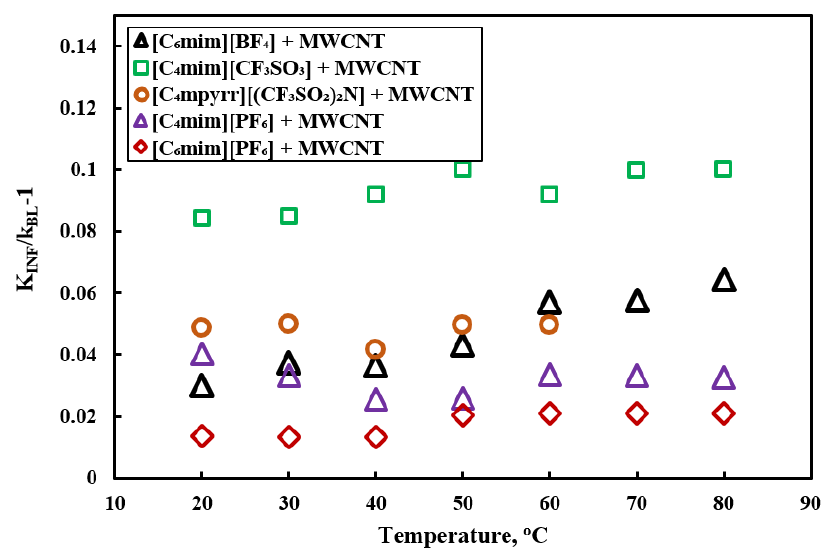
Figure 10. Comparison between MWCNTs-dispersed ILs as a function of temperature [61]. Reproduced with permission from [Nieto de Castro], [J. Chem. Eng. Data]; published by [ACS], 2010.